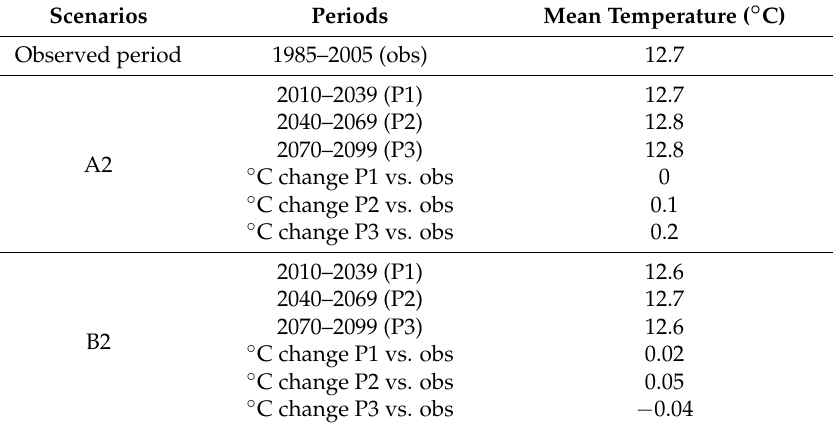
Table 3. Results of the daily mean temperature predictions of the HadCM3 scenarios for the